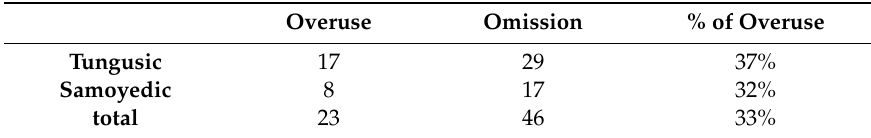
Table 2. Overuses vs. omissions of - s j a .